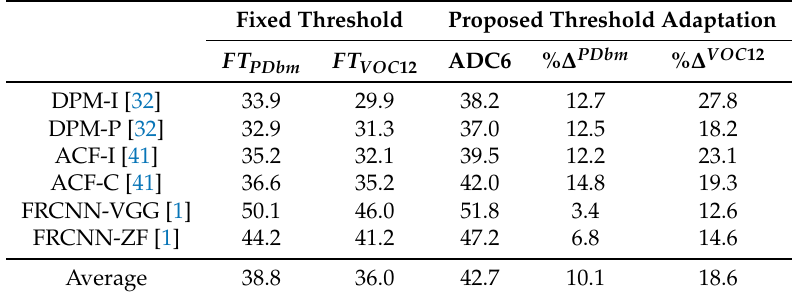
Table 5. Comparison in terms of average FScore between two fixed thresholding approaches and the ADC6 over PDbm dataset. Percentage increase (% ∆ PDbm and % ∆ VOC12 ) calculated with respect to the fixed thresholding approaches, FT PDbm and FT VOC 12 , respectively.